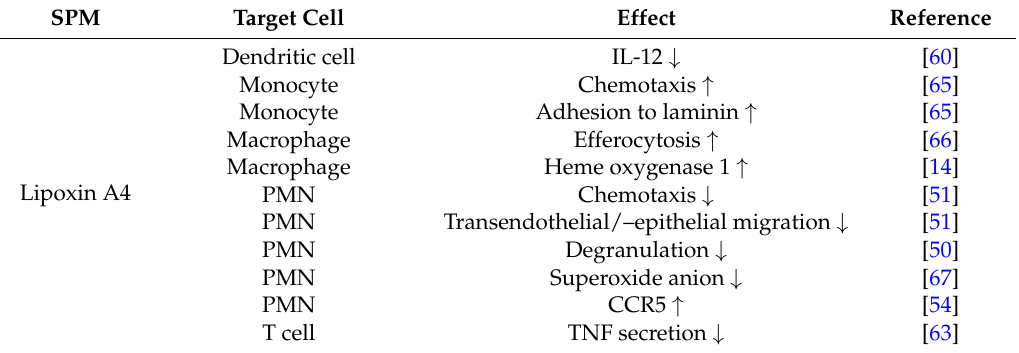
Table 1. Key effects of “specialized pro-resolving mediators” (SPM) in mononuclear and polymorphonuclear leukocytes (PMN).